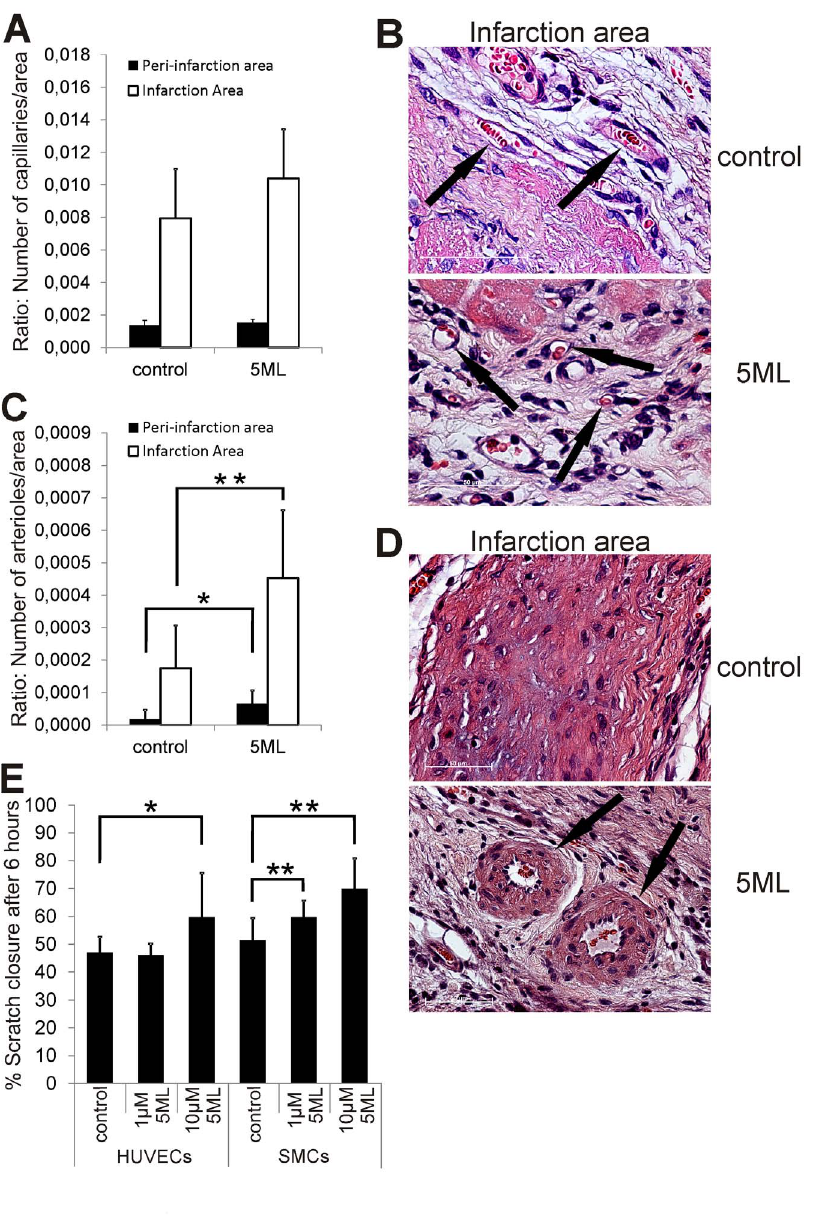
Figure 6. 5ML treatment induces arteriogenesis in the peri-infarction and infarction area of rat hearts after MI and activates the migration ability of smooth muscle cells as well as endothelial cells. Figure 6A shows the quantification of the capillary density in the infarction and peri-infarction area on HE stained heart sections (n=7 per group). Representative images of capillaries in the infraction area are shown in Figure 6B (black arrows; magnification 100 6 ). Quantitative image analysis of the arteriole density in the peri-infarction and infarction area of all animals (n=7 per group) are shown in Figure 6C and representative images of arterioles in the infarction area are shown in Figure 6D (black arrows; magnification 63 6 ). The effect of 5ML in an in vitro wound scratch assay with HUVECs and SMCs is depicted in Figure 6E (data are expressed as% scratch closure after 6 hours). The in vitro experiments were performed in triplicates. Asterisks indicate significant differences (* p , 0.05; ** p , 0.01) compared to the corresponding controls or control group.